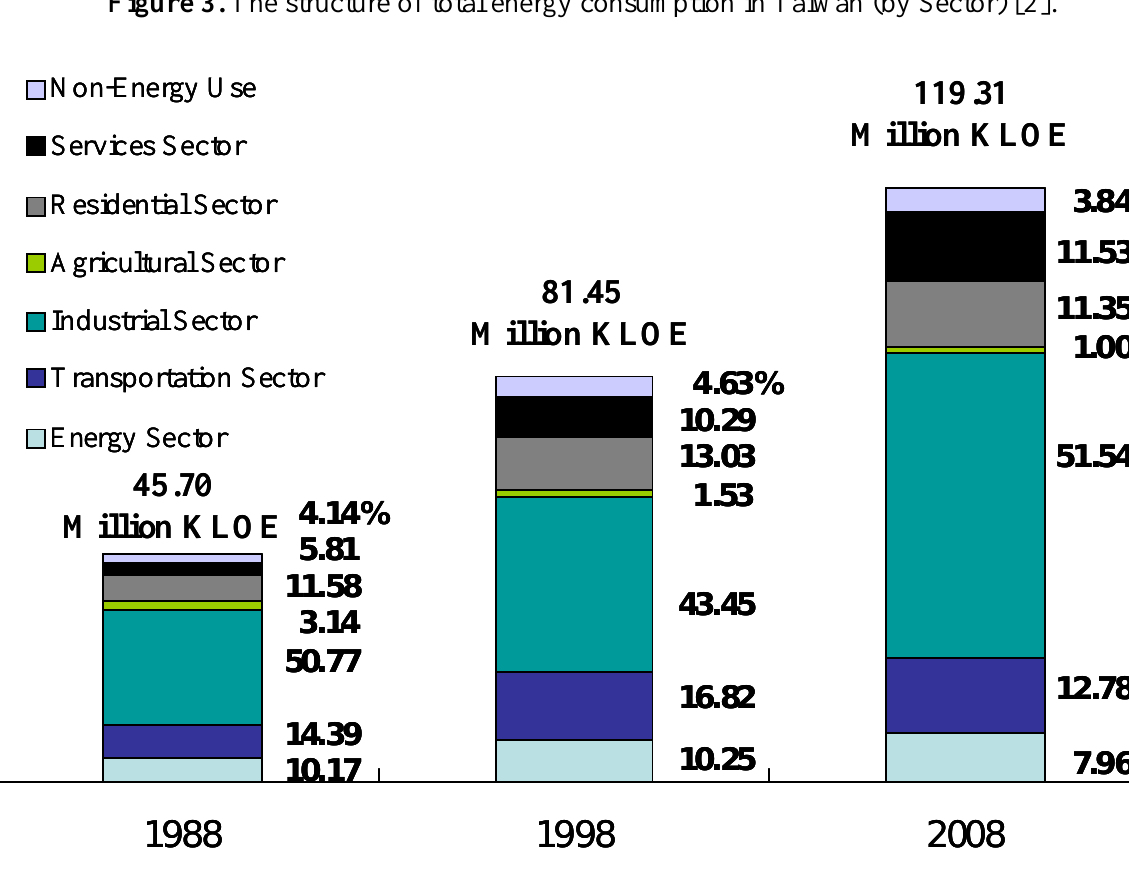
Figure 3. The structure of total energy consumption in Taiwan (by Sector)